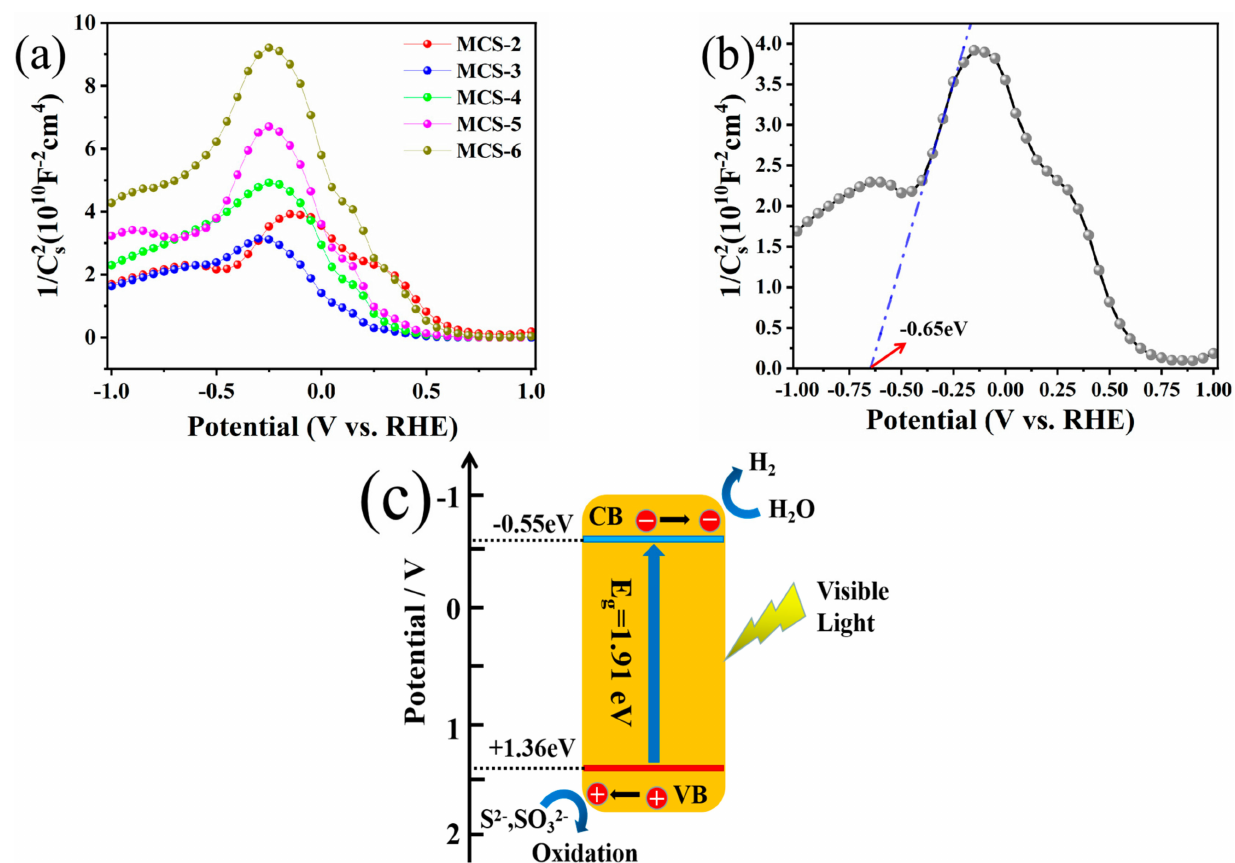
Figure 9. ( a ) Mott–Schottky curves of different MCS products. ( b ) Mott–Schottky curves of MCS-2. ( c ) Energy band diagram of MCS-2 alone.